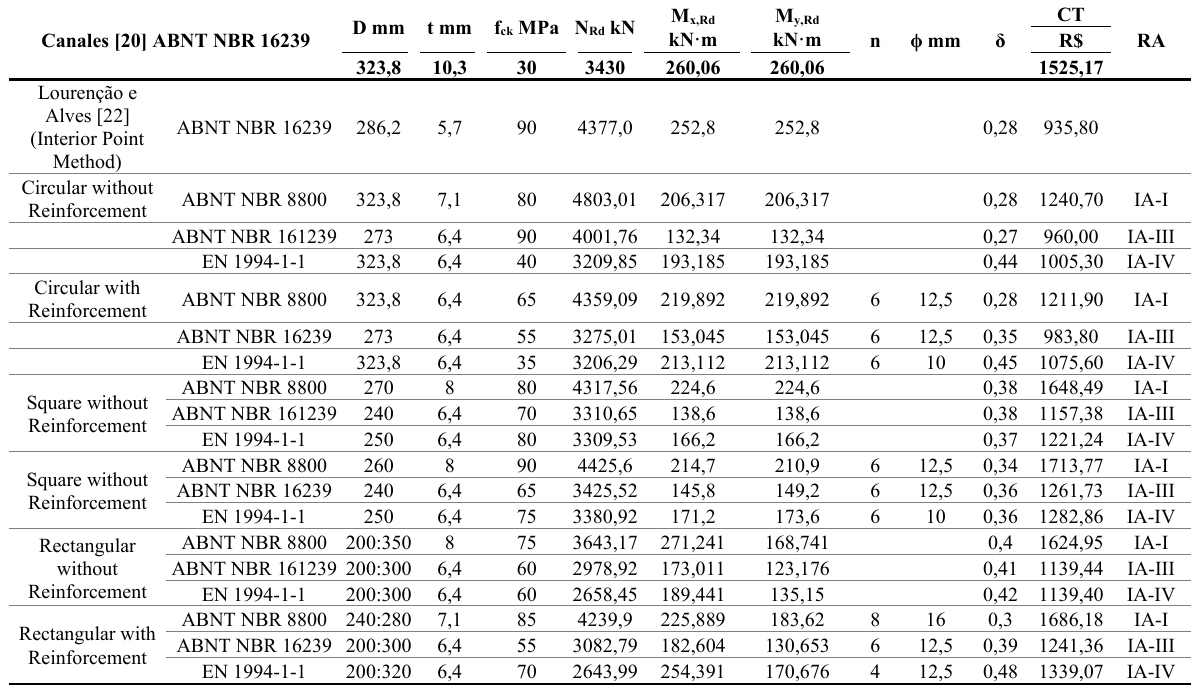
Table 5 – Optimization Results Example 2: L=4m; N Sd =2000kN; M x,Sd =132kN ⸱ m Canales [20] ABNT NBR